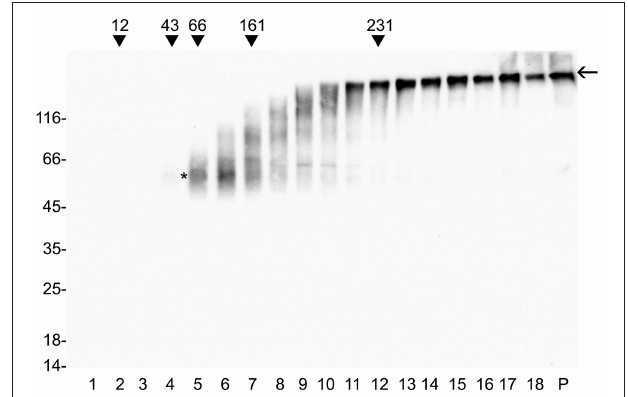
FIGURE 5 | zein-hBMP2ad assembles both in dimers and in progressively larger multimers. Eight hundred micrograms of total leaf proteins from zein-hBMP2ad line #7 were extracted in the absence of 2-ME and fractionated by velocity sucrose (5–25% w/v) gradient centrifugation. Equal volume of fractions and the pellet at the bottom of the tube were analyzed by protein blot with anti-Flag antiserum. Asterisk indicates zein-hBMP2ad dimers. Arrow indicates the interface between stacking and separating gels. P: pellet at the bottom of the tube. Numbers on the top indicate the position along the gradient and the molecular mass (kD) of velocity centrifugation markers. Numbers on the left indicate the positions of molecular mass markers, in